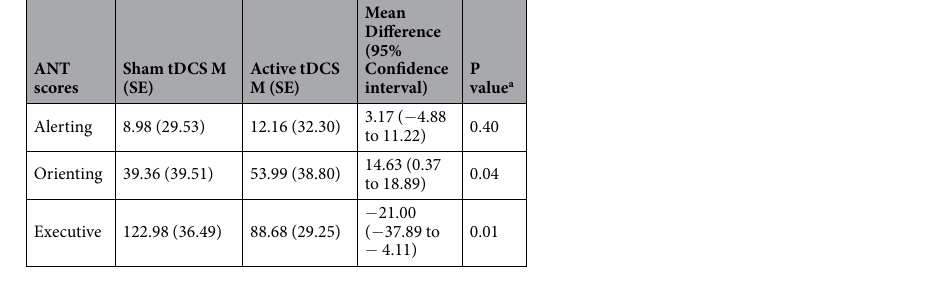
Table 3. Means and Standard Errors (SE) for the Primary Outcomes (scores of Alerting, Orienting and Executive Attention in the ANT) according to Group (a-tDCS + Go/no-Go Task vs. s-tDCS + Go/no-Go Task) (n = 35). a Values based on a mixed ANOVA model. Significance level was P <